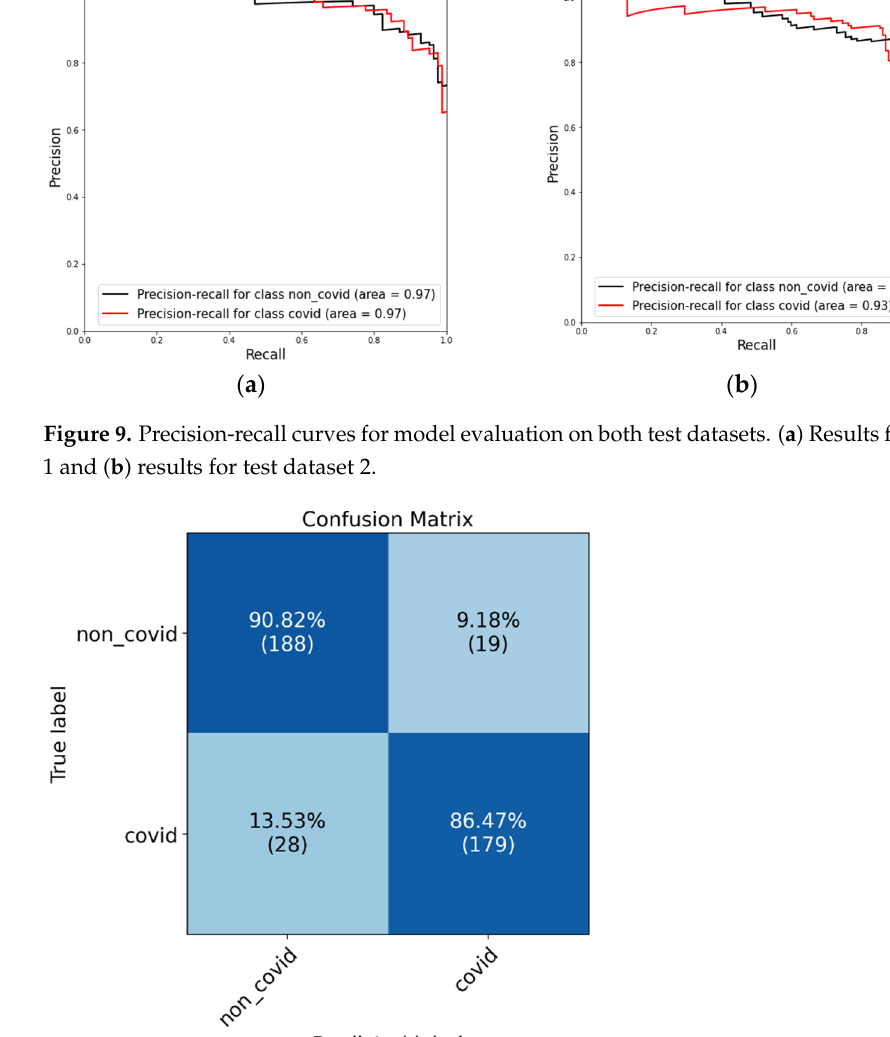
Figure 10. Confusion matrix for model evaluation on the combined test dataset.